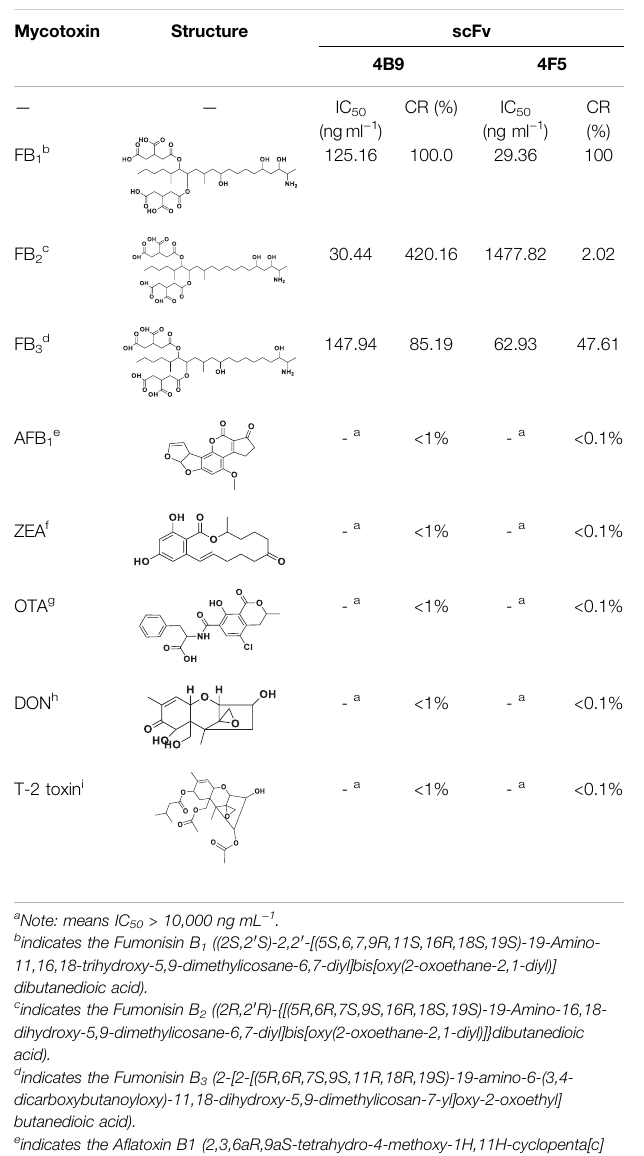
TABLE 1 | The detection parameters of 8 mycotoxins by 4F5 and 4B9